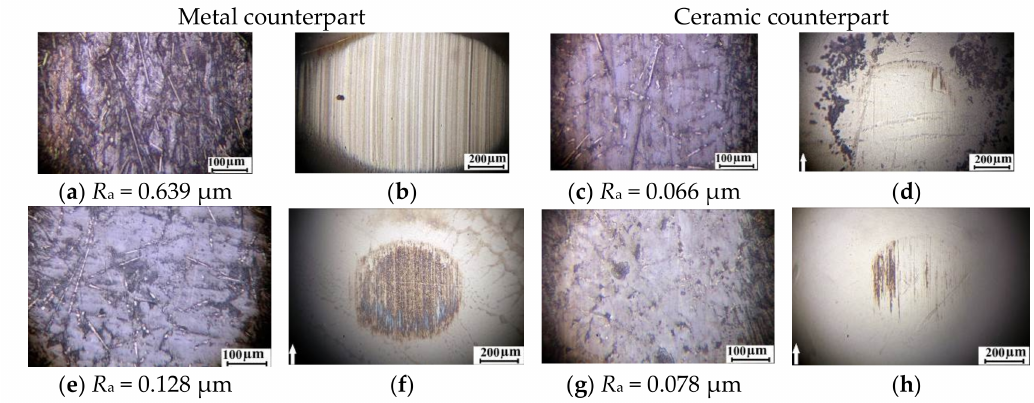
Figure 12. Optical images of the wear track (sample) surfaces and the counterparts at the steady state wearing stage: ( a – d ) PPS + 15% PTFE + 22.5% CF and ( e – h ) PEEK + 15% PTFE + 20%